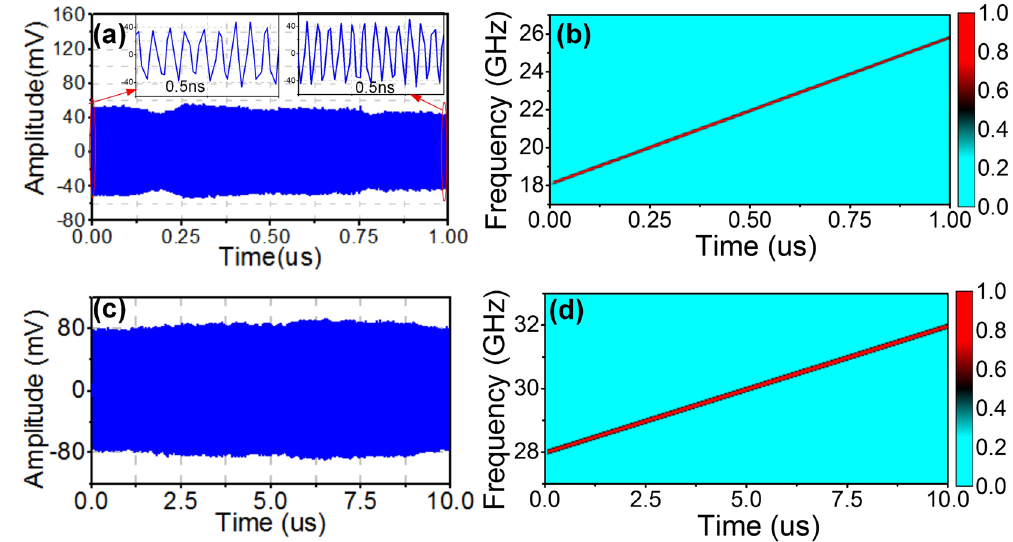
Figure 3. Results of broadband and reconfigurable LFM signal generation. ( a ) and ( b ): waveform and frequency of the generated 8-GHz LFM signal with a central frequency of 22 GHz and a repetition rate of 1 MHz; ( c ) and ( d ): waveform and frequency of the generated 4-GHz LFM signal with a central frequency of 30 GHz and a repetition rate of 100